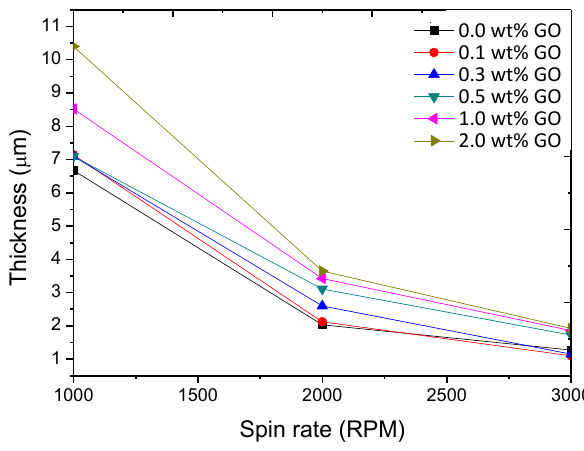
Figure 9. The thickness to spin rate of the GO-doped PVDF film spin-coating.